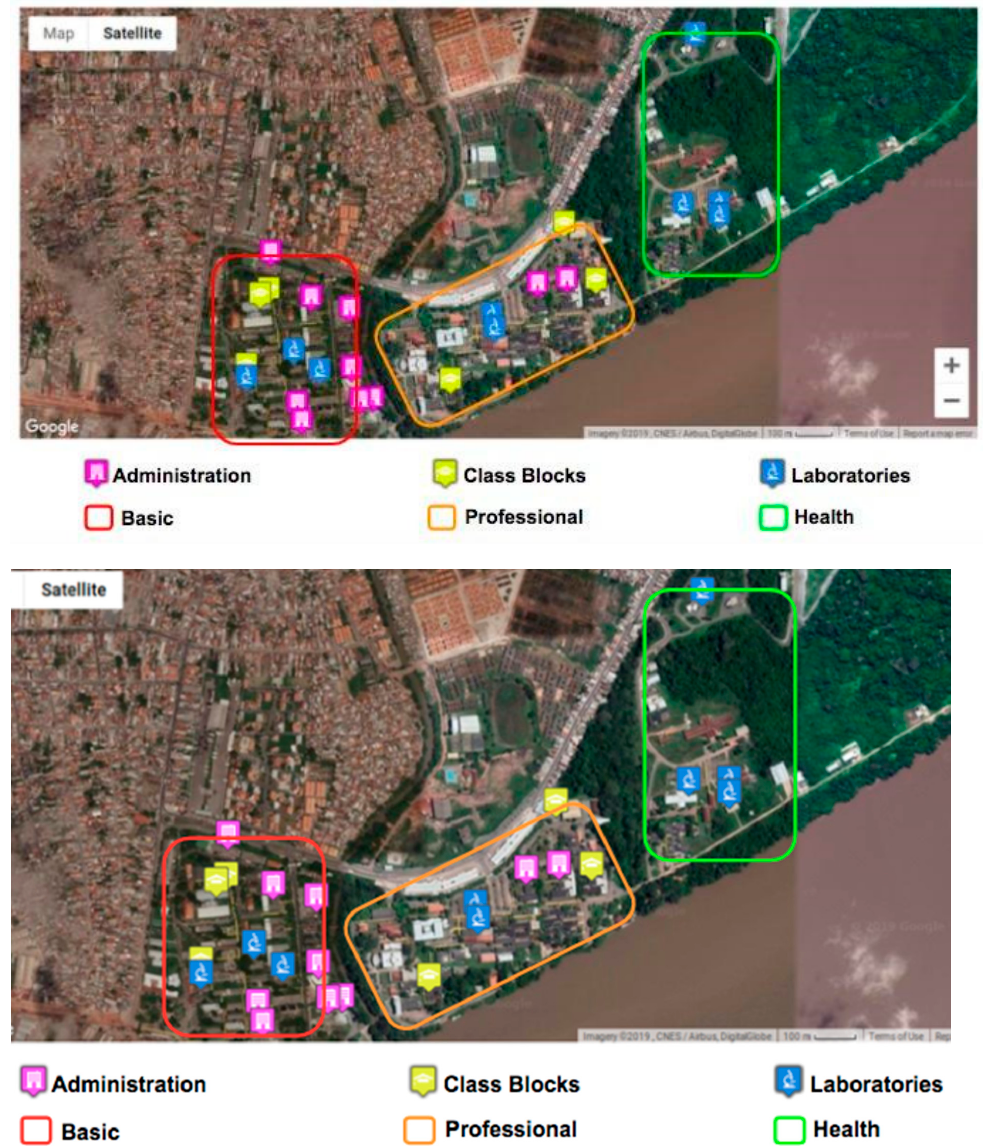
Figure 5. Federal University of Para Campus located in Belém City-Brazil (Adapted from Google Map).